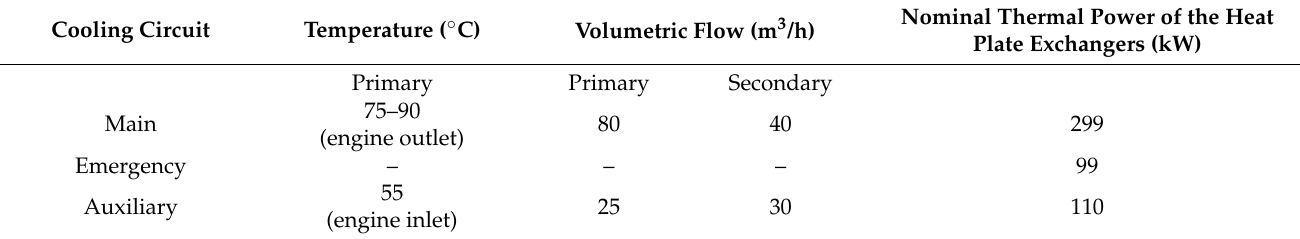
Table 4. Parameters of the three cooling circuits of the